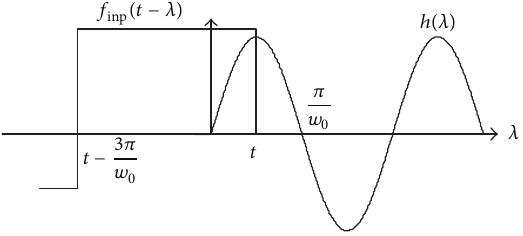
Figure 17: We “discover” the Fourier series using graphical convo- lution. The convolution of ℎ(𝑡) with the square wave having 𝑇 = 3𝑇 𝑜 .